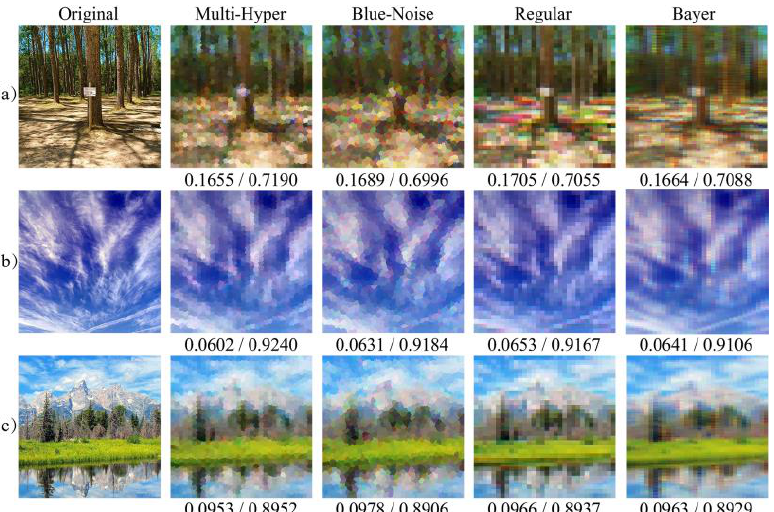
Figure 7. Comparison of reconstructed images of natural scenes using different sampling patterns. From the left to right are the original images, reconstructions from multi-hyperuniform, blue-noise sampling patterns, regular and Bayer sampling patterns. The corresponding RMSEs and SSIMs are listed below the images, respectively. ( a ) The scene of forest and corresponding reconstructed image; ( b ) The scene of sky and corresponding reconstructed images; ( c ) Natural scene with the different contents and corresponding reconstructed